Question: Describe this figure in one sentence.
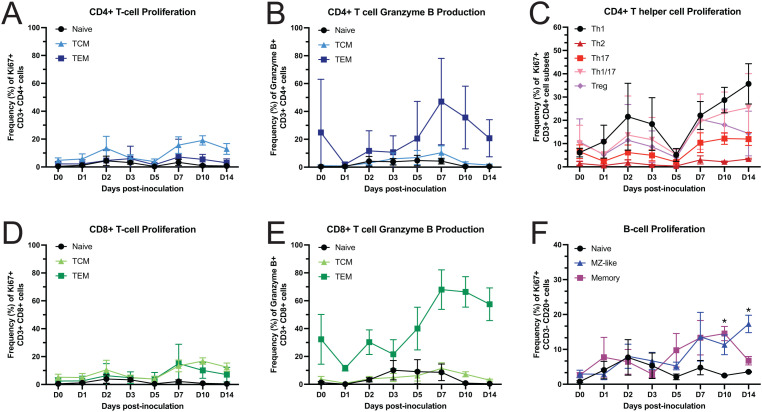
Answer: Kinetics of T cell proliferation and granzyme B expression in peripheral blood. Whole blood from ONNV+ rhesus macaques was processed to remove plasma and lyse red blood cells prior to staining with antibodies against lineage (CD3, CD4, CD8), proliferation (Ki67), and activation marker (granzyme B) followed by flow cytometry analysis. Changes in the longitudinal frequency of proliferating naïve, central memory, and effector memory CD4 + T-cells (A) and CD8 + T-cells (D) as well as granzyme B expression (granzyme B+) by CD4 + T (B) and CD8 + T cells (E) are shown and proliferating CD4 ⁺ T helper subsets (Th1, Th2, Th17, Th1/17) (C) . B cell (CD3-CD20+) responses were separated into naïve, marginal zone (MZ)-like, and memory subsets and quantified for Ki67+ (proliferation). Lines represent mean frequencies of the six animals and error bars represent the standard error of the mean. Longitudinal changes were analyzed in Prism using a one-way repeated-measures ANOVA (time) with the Geisser–Greenhouse correction, followed by Sidak’s multiple comparisons test to compare each post-challenge day to baseline (day 0) within groups. Significance is shown as: p < 0.05 (*); all other comparisons were ns (p ≥ 0.05). Analysis was performed in GraphPad prism v10.2.0.